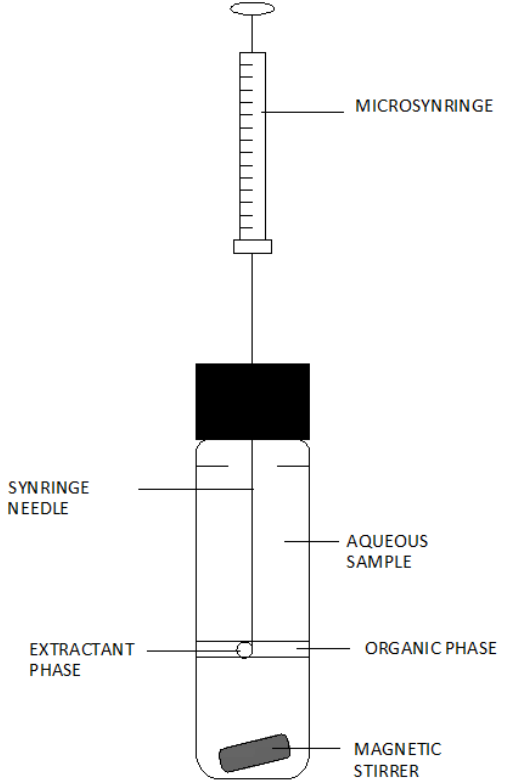
Figure 4. A diagram of the set for liquid–liquid–liquid microextraction. Based on Pena-Pereira, F. et al.